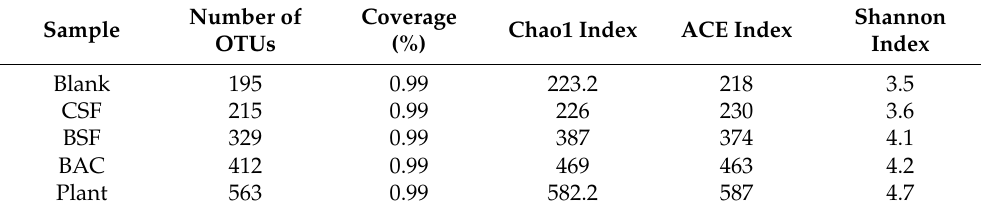
Table 2. Statistics of α diversity index among sandy soil